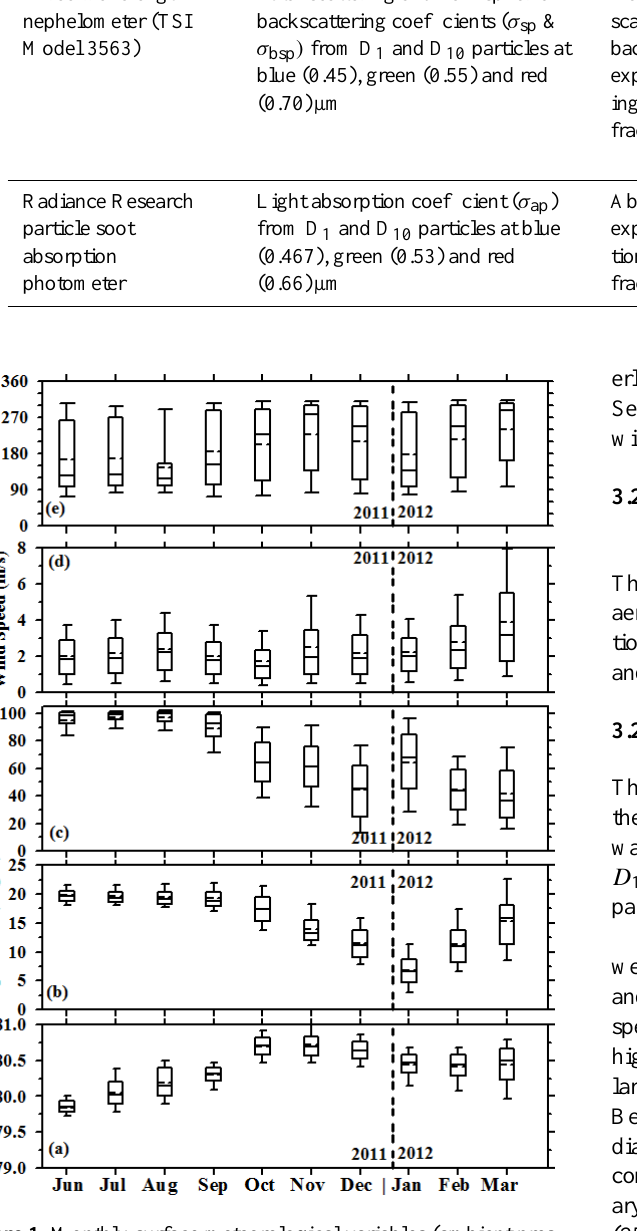
Figure 1. Monthly surface meteorological variables (ambient pres- sure, air temperature, relative humidity, wind speed and direction) at Nainital during the period June 2011 to March 2012 in box-and- whisker charts. The dashed line represents the mean and the solid line the median. The box contains the range of values from 25% (bottom) to 75%